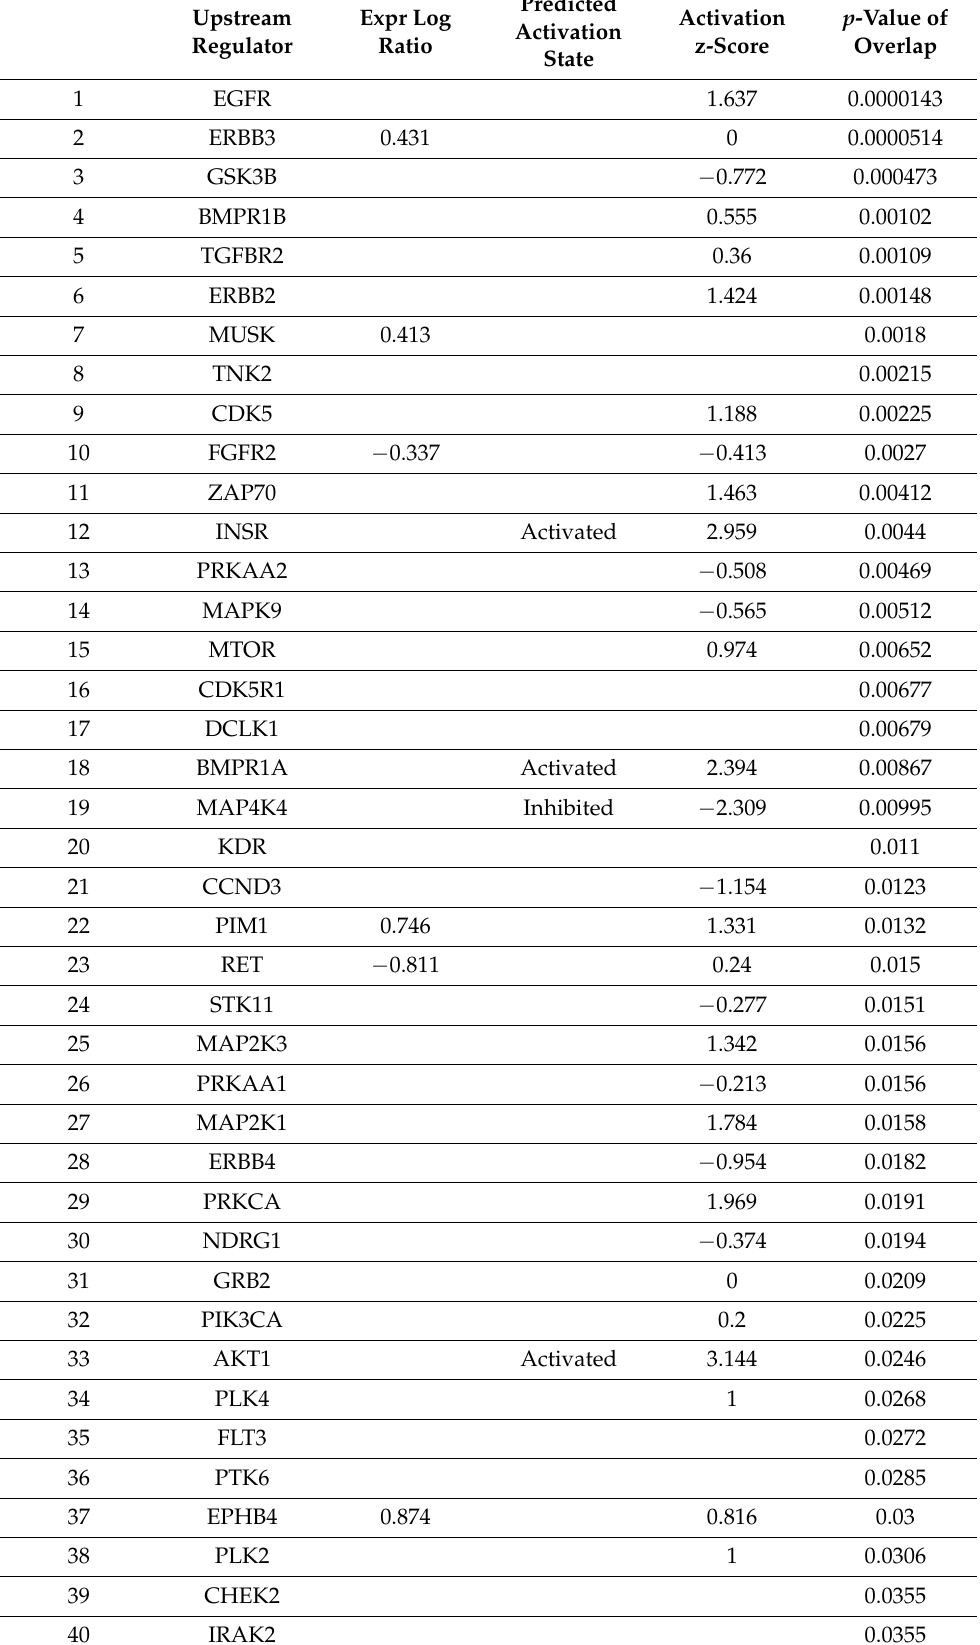
Table 8. The kinases identified as Upstream Regulators by the Ingenuity Pathway Analysis of the Gene Expression Omnibus dataset on unilaterally nephrectomized mice (GSE